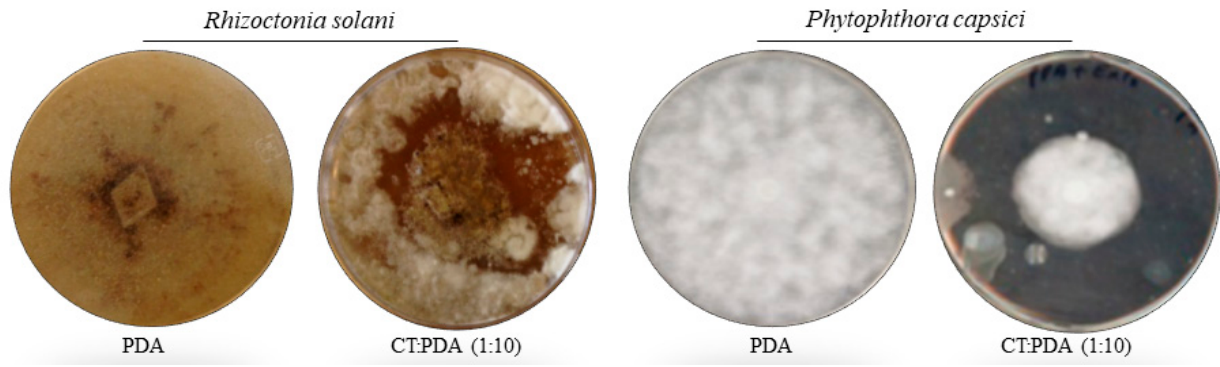
Figure 3. Effect of CT on the relative growth rate of R. solani and P. capsici in comparison to control treatment. Table 2. Relative growth rate of R. solani and P. capsici in CT treatment. Results are indicated as mean ± standard deviation.